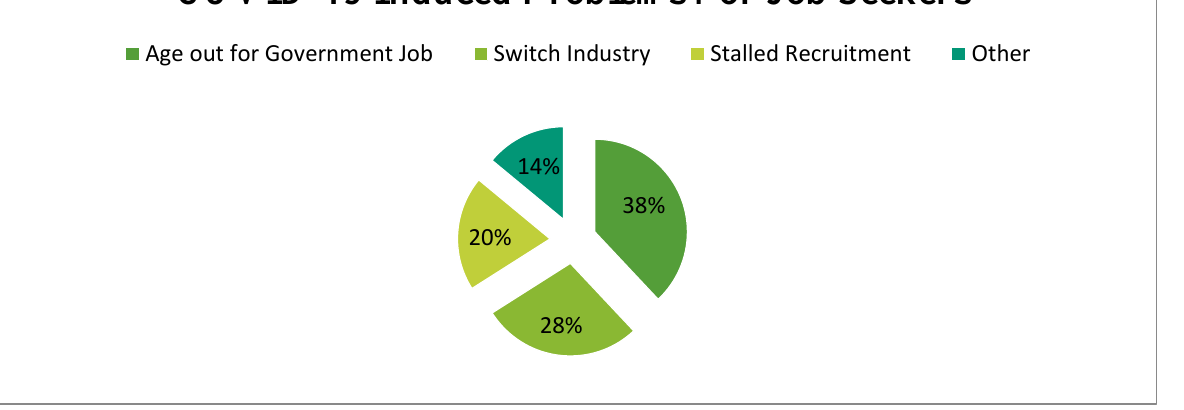
Figure 7 : Figure 7 shows that, among the challenges induced by COVD-19 to enter the job market three problems are most prevalent. Among the respondents, 19 job seekers fears the age out for public job, 14 respondents finding it hard for them to switch job industry, and 10 respondents find the stalled recruitment as disruptive challenge for their career. Only 7 respondents identified challenges like maintain hygiene, long distance and family